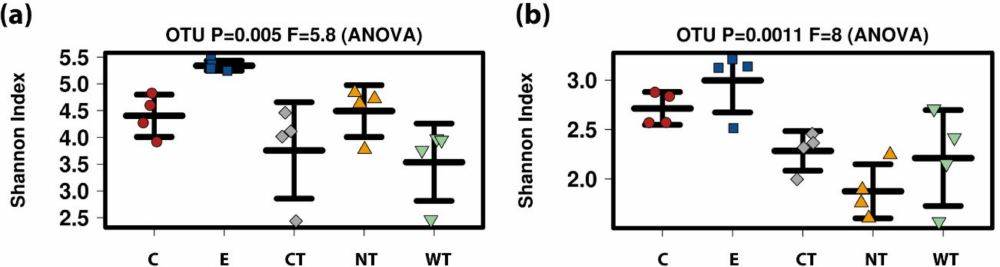
Figure 7. Boxplots of alpha-diversity index (calculated as Shannon index) ( a ) 16S. ( b ) ITS. (C: cinnamon; E: ethanol; CT: common thyme; NT: not-treated control; WT: wild